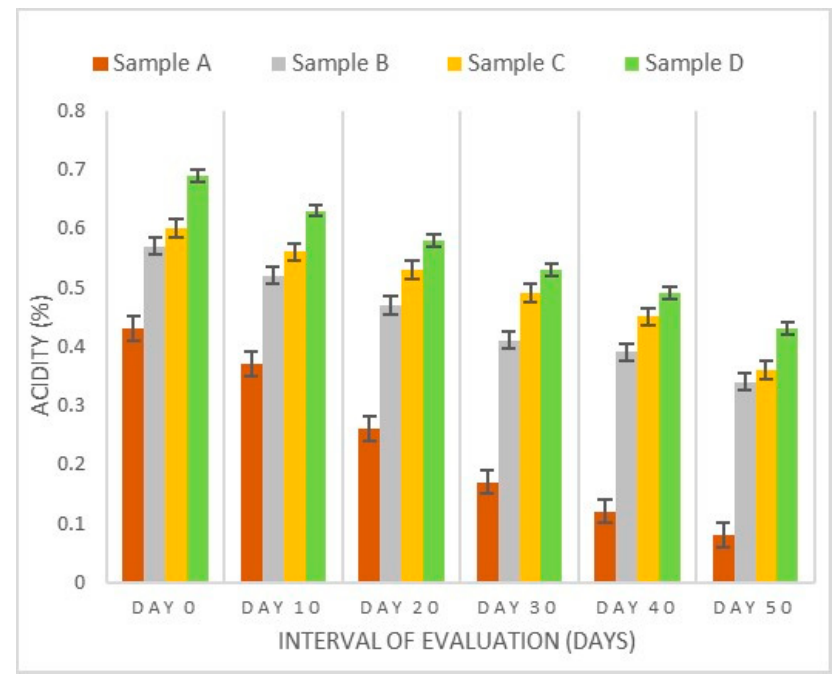
Figure 4. Acidity (%) evaluation of samples.